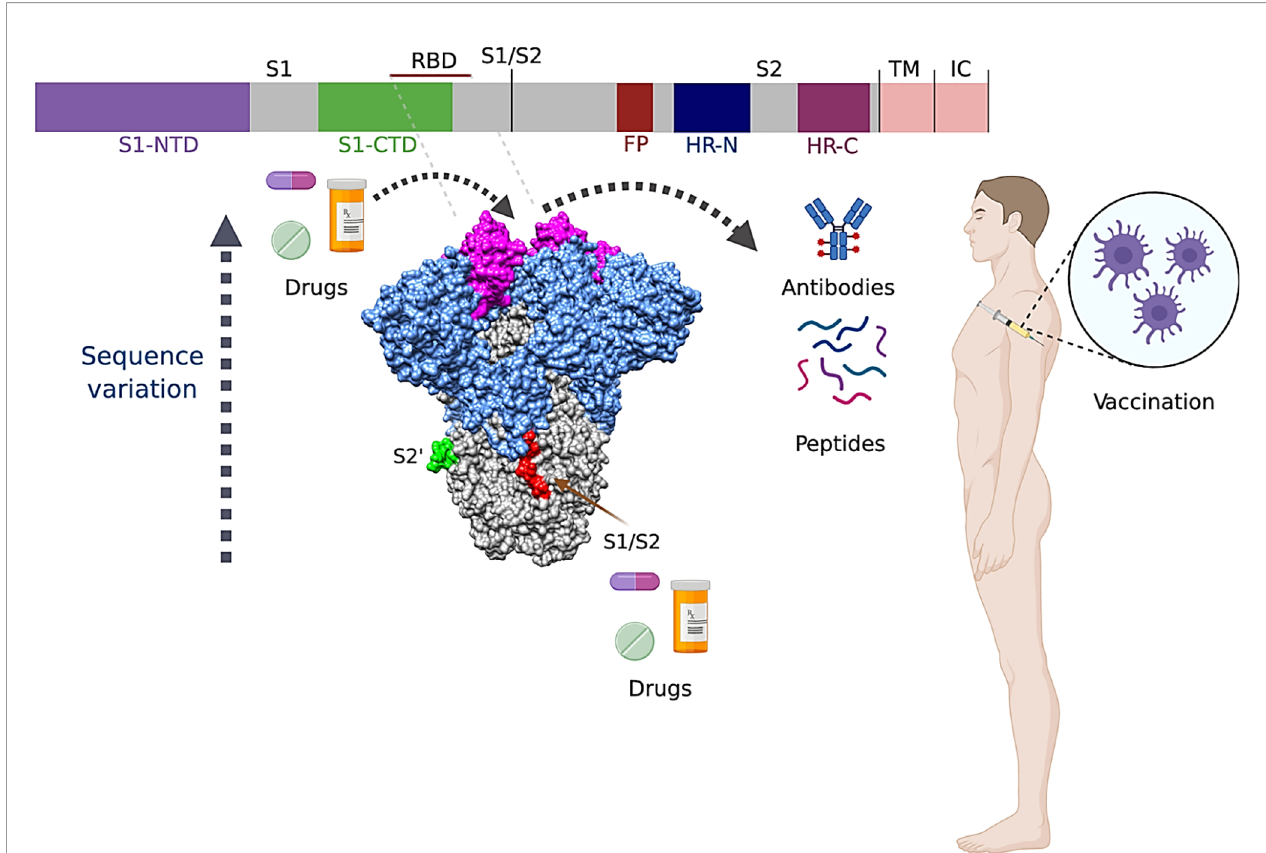
FIGURE 5 | Summary of Spike protein targeted therapeutics. Sequence variability increases in the sense of S2 (gray) and S1 (blue) domains, and reaches its apices on the RBD (dark pink). Regions used for drugs, peptides, antibodies, and vaccine development are indicated with dark gray